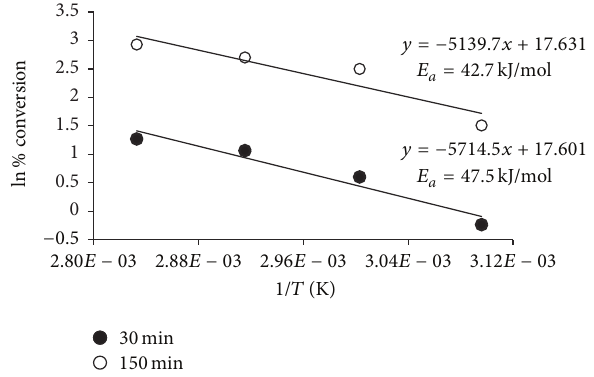
Figure 7: Arrhenius plot for the reaction of cyclohexanol to cyclohexanoneat30 minand150min. Reaction conditions :Cat,0.1g; cyclohexanol, 10 mL; flow, 40 mL/min; pO 2 , 760 torr; and stirring, 900